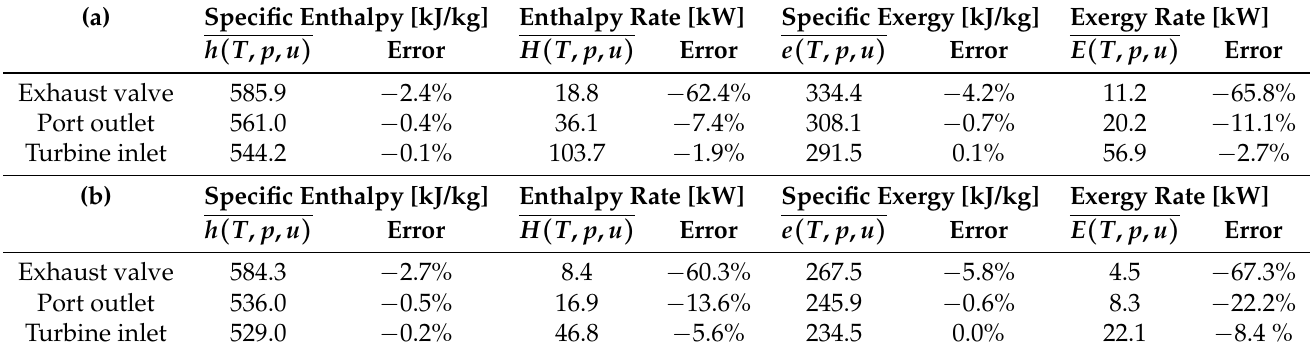
Table 4. Cycle-averaged enthalpy and exergy transport by exhaust flows.